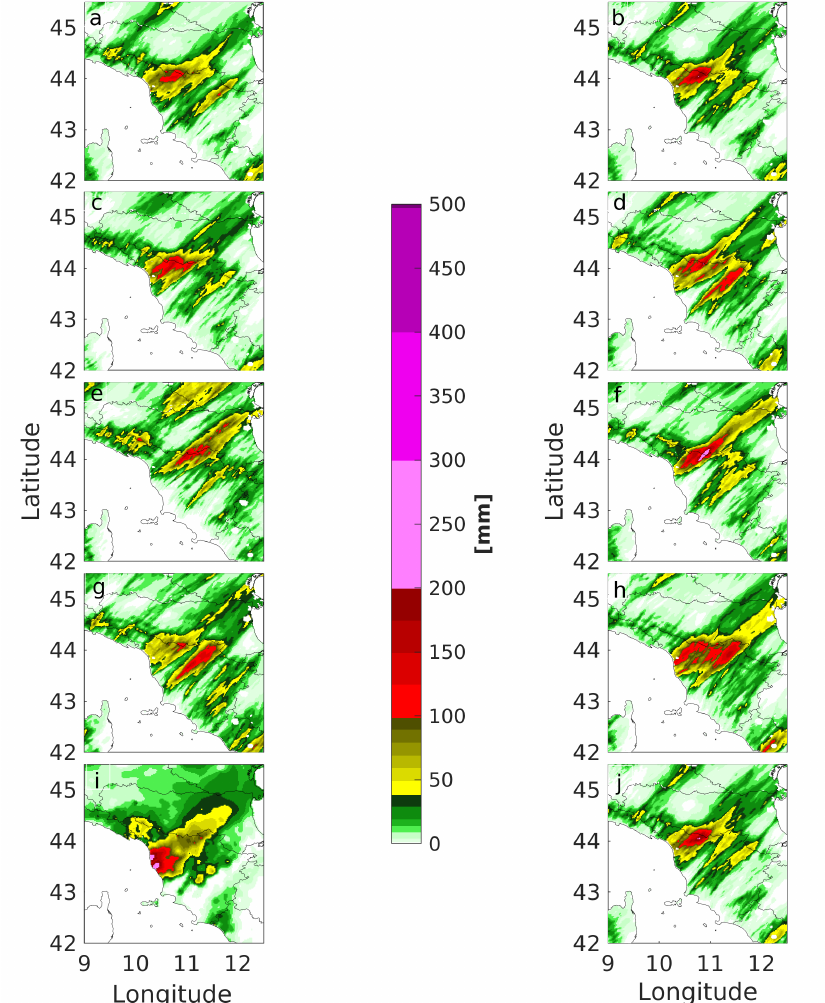
Figure 8. GFS-driven cases. Quantitative Precipitation Forecast (QPF) values for the 12 h time period from 18UTC on 9 September 2017 to 06UTC on 10 September 2017, where ( a ) = LST, ( b ) = SST, ( c ) = SM, ( d ) = WIND, ( e ) = ZTD_GNSS3h, ( f ) = ZTD_GNSS3h_1ist, ( g ) = WIND+SM+ZTD_GNSS3h_1ist, ( h ) = WIND+SM+ZTD_GNSS3h_1ist_18UTC (only 18UTC), ( i ) = OBS, ( j ) = OL. For details about the different ingestion approaches the reader is referred to the main